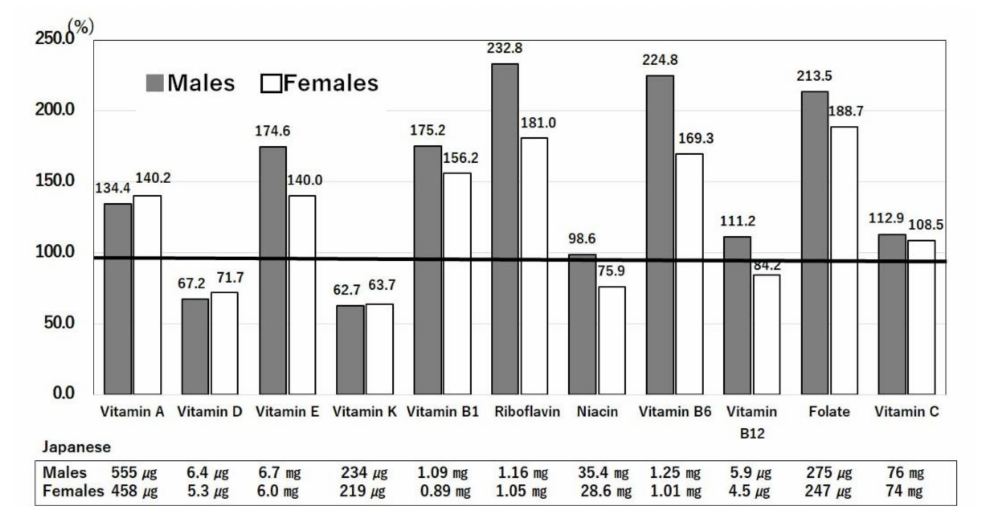
Figure 6. Ratios of vitamin intakes in the U.S. compared with Japan. Intakes of vitamins by Japanese men and women were set to 100% and compared with the intakes by American men and women. The actual values of Japanese intakes are shown below each bar. The age range is 40–49 years. United